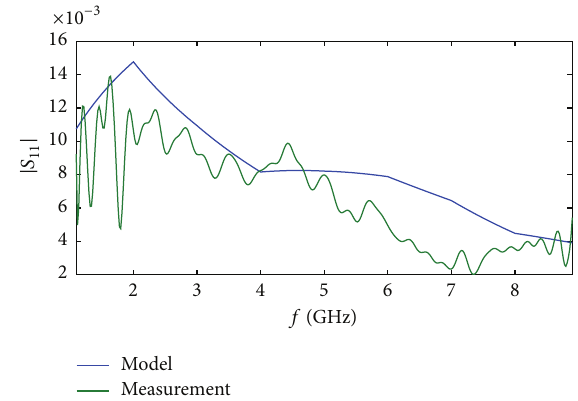
Figure 2: Comparison between the model prediction and the measurement for the module of the reflection coefficient.